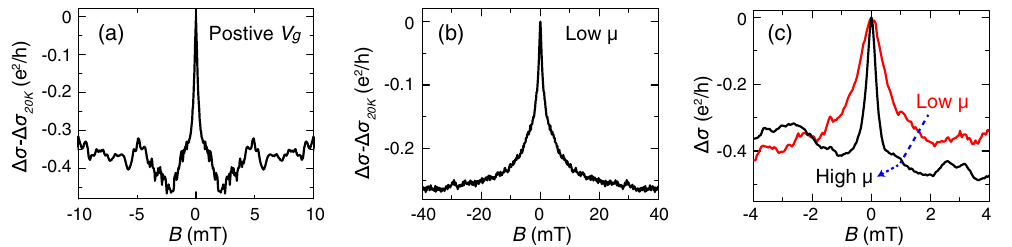
FIG. 3. Interfacially induced SOI in graphene-on-TMD is a robust phenomenon. (a) Magnetoconductivity of graphene-on-WSe 2 measured with the Fermi energy gate-tuned to be in the graphene conduction band. (b) Magnetoconductivity due to WAL measured on a larger-area graphene-on-WSe 2 device with a carrier mobility of only 3000 cm 2 = Vs. (c) Magnetoconductivity of graphene-on-WS 2 measured on the same device before (red) and after (black) the AFM-ironing process needed to clear graphene from adsorbates. As the carrier mobility increases, the WAL peak becomes sharper, as expected. All data in this figure have been measured at T ¼ 250